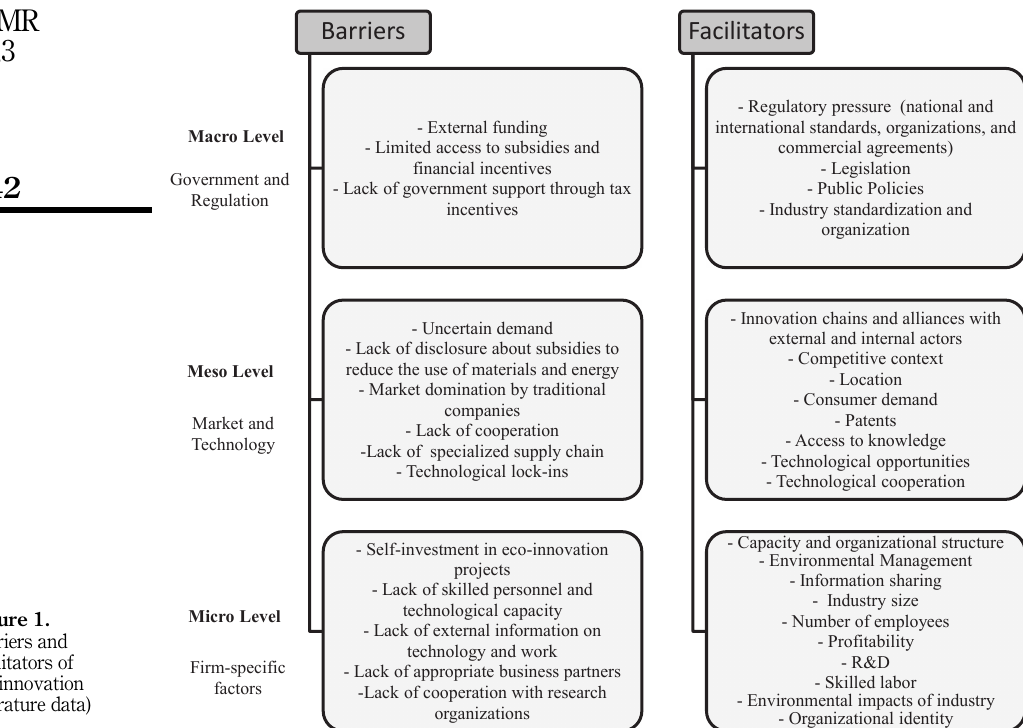
Figure 1. Barriers